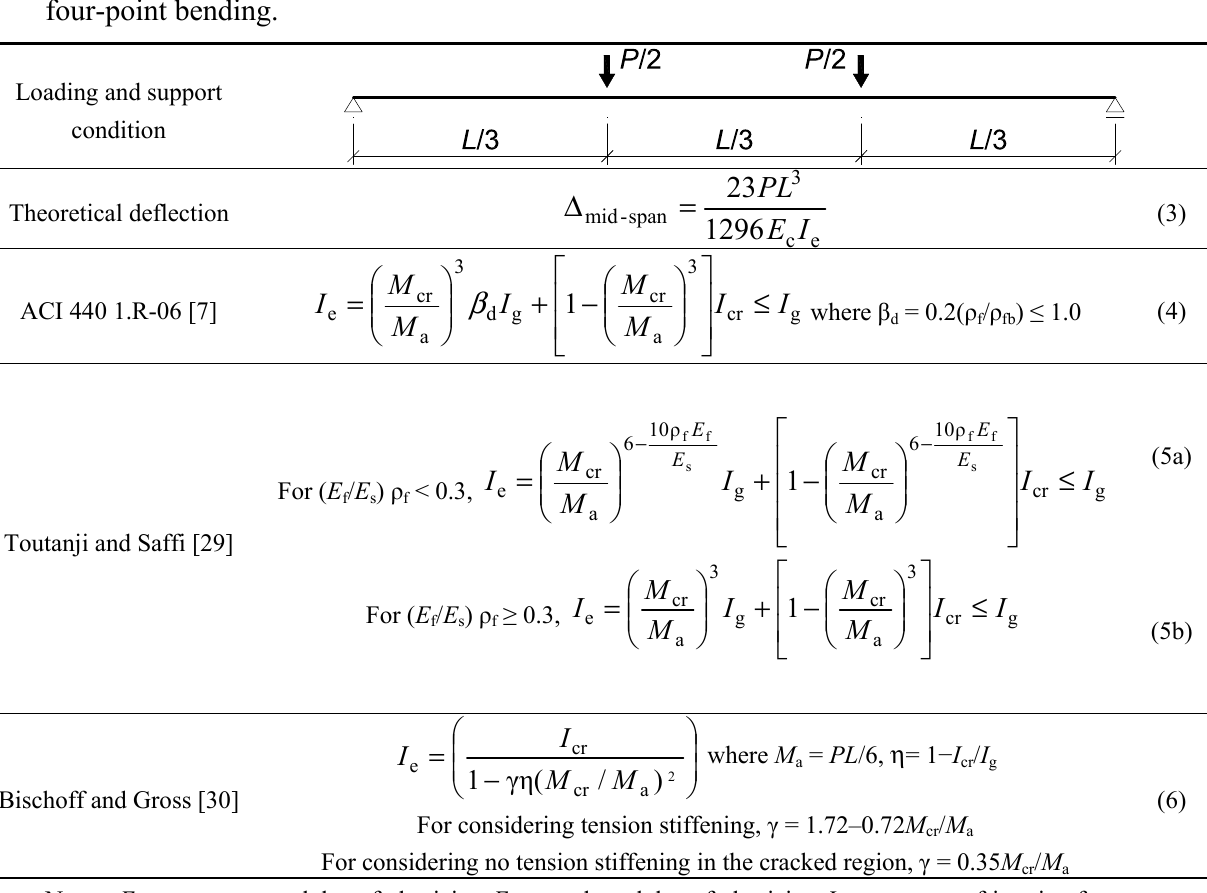
) for the calculation of deflections under the e